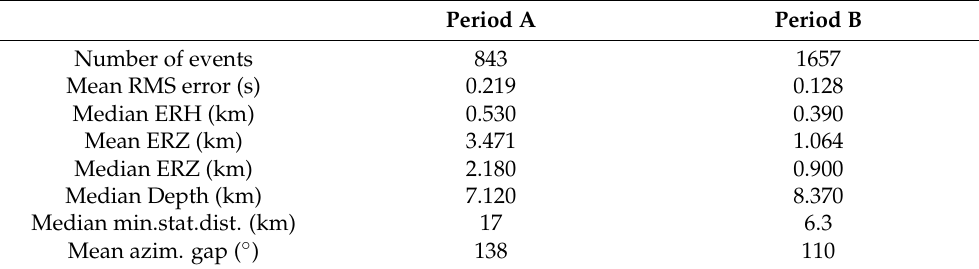
Figure 8. Seismicity of the study region for the period between 1 June and 18 October 2021. ( a ) Initial locations with HypoInverse, ( b ) results of double-difference relocation with HypoDD. Colors and numerical labels in panel ( b ) represent the foreshock swarm activity (group #1, red) and the three spatial aftershock groups: #2 (cyan) middle, sparse group, #3 (blue) northern cluster near Kastelli airport, #4 (green) southern group, including the mainshock. Major events ( M ≥ 4.5) are depicted as stars. Profile line A-B in panel ( b ) is used for the spatiotemporal projection of Figure 9. The location of Arkalochori village is marked with a black square. Table 2. Initial location statistics for Period A (1 June–27 September 2021, V P /V S = 1.78, long-distance weighting) and Period B (28 September–18 October 2021, V P /V S = 1.76, short-distance weighting). ERH, ERZ are horizontal and vertical location errors, “min.stat.dist” denotes the epicentral distance of the closest station with available arrival-time data (see also Figures S3 and S4 in the Supplementary